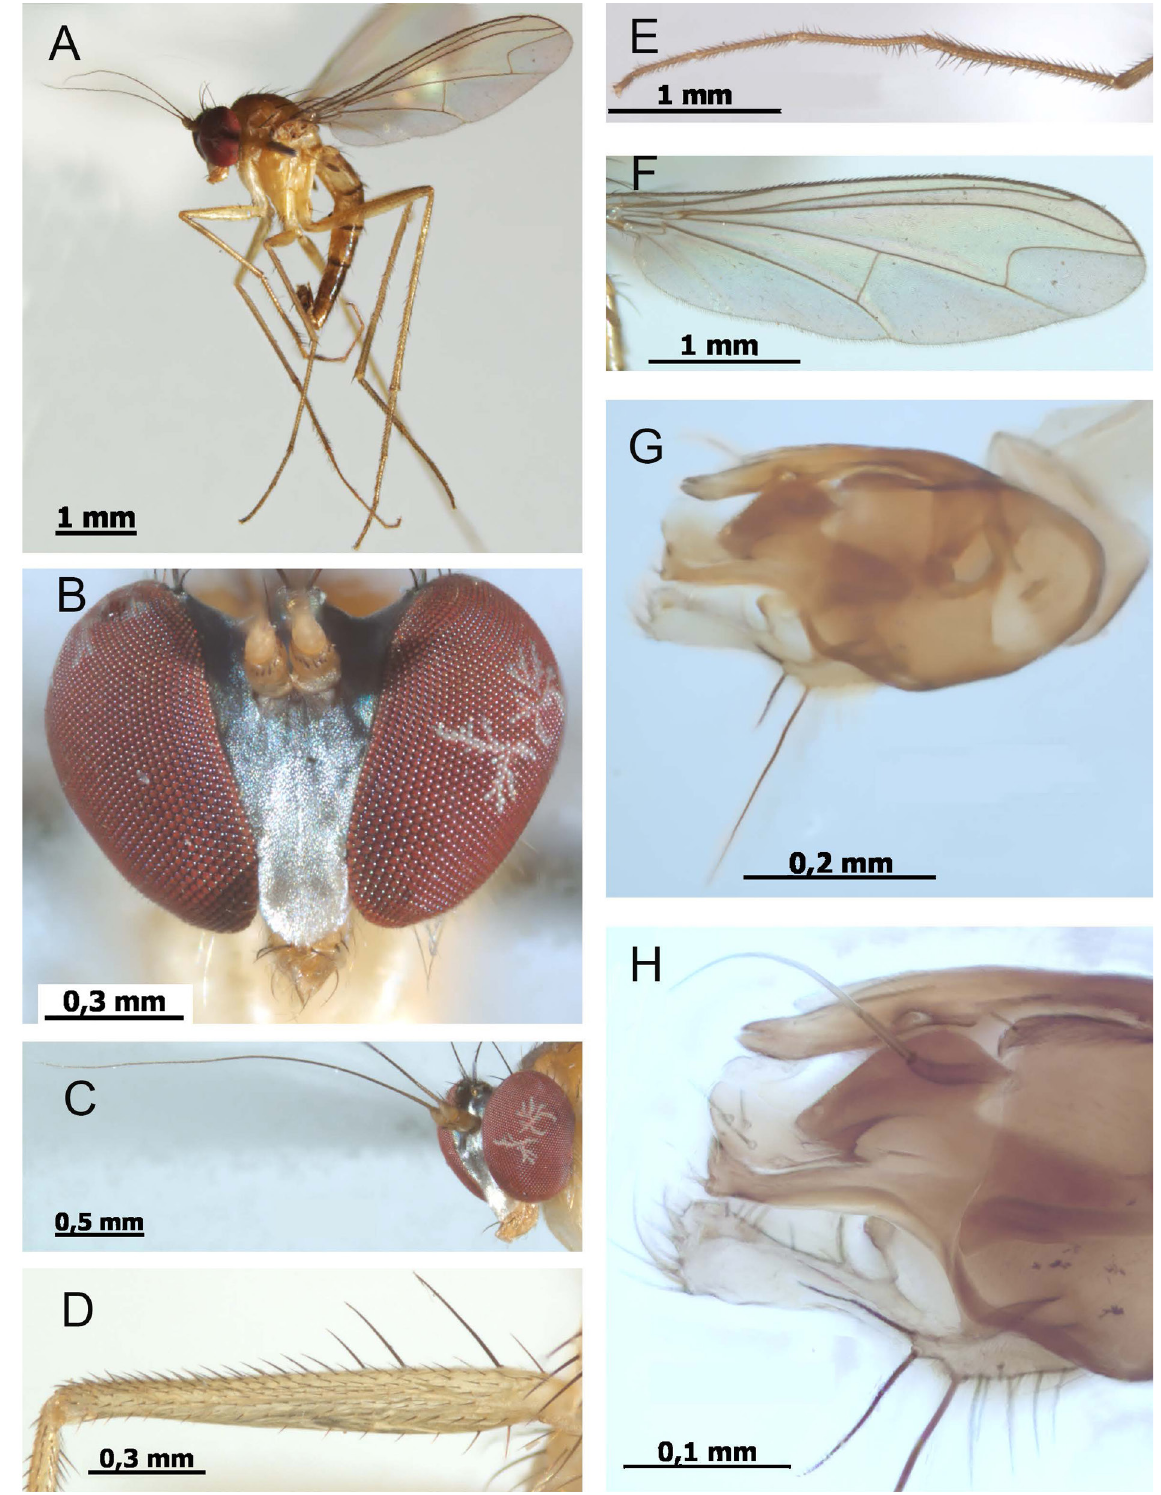
Fig. 6. Amblypsilopus romani sp. nov. A–F . Holotype, ♂ (SMNHTAU). G–H . Paratype, ♂ (SMNHTAU). A . Habitus. B . Head, frontal view. C . Head and antenna, frontolateral view. D . Fore femur. E . Fore tarsus. F . Wing. G . Hypopygium, left lateral view, reflected light. H . Distal appendages of hypopygium, transmitted